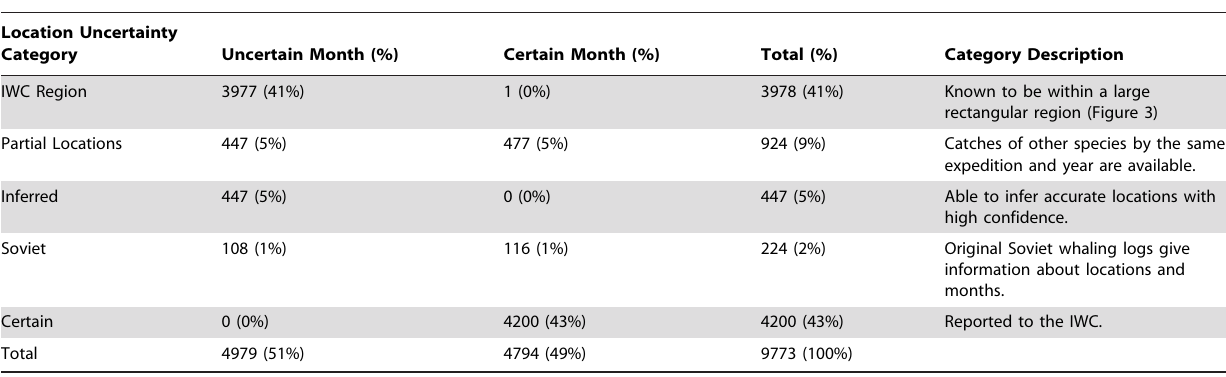
Table 1. North Pacific blue whale catches by categories of uncertainty.